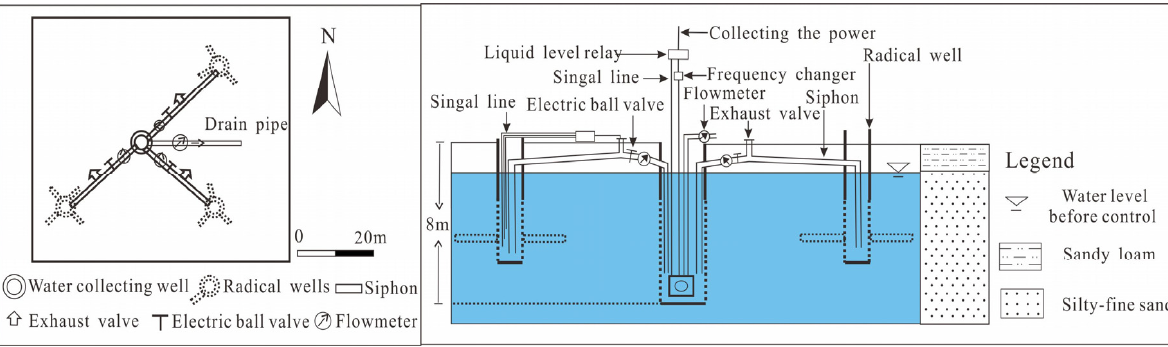
Figure 3. Intelligent groundwater control system for salinization prevention in farmland around wetlands.